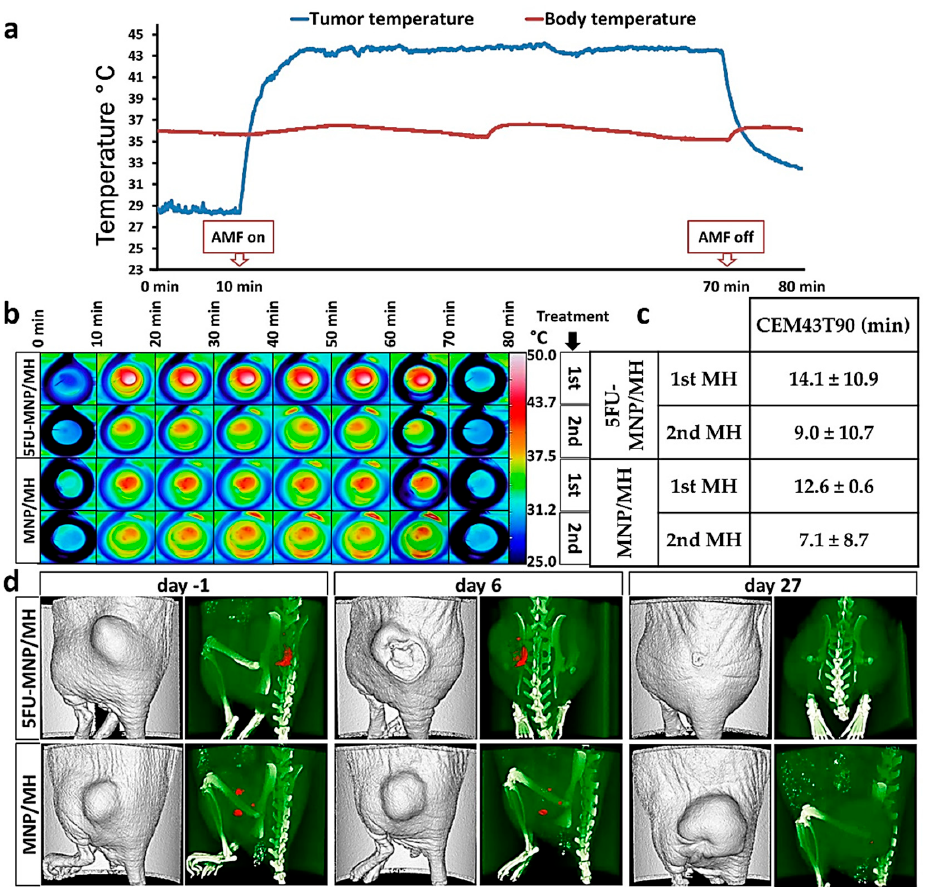
Figure 1. Monitoring the real-time temperature of the tumor and body led to an effective application of magnetic hyperthermia. ( a ) Representative diagram of tumor and rectal temperatures after MNP injection (CS-MNP and 5FU-CS-MNP, 0.25 mg Fe per 100 mm 3 tumor tissue and 0.22 to 0.55 mg 5FU per kg body weight) and exposure to an AMF (60 min at H = 15.4 kA/m, f = 410 kHz), ( b ) heat maps of the tumor surface temperatures as recorded with a thermographic camera, ( c ) mean CEM43T90, calculated for magnetic hyperthermia treatments and ( d ) representative µCT overlay images (bones: white, MNPs: red) taken at 24 h before the first (day − 1) and second tumor therapy (day 6) and 24 h before the animal sacrifice (day 27) showing the clearance of MNPs over time. AMF: alternating magnetic field; MH: magnetic hyperthermia; µCT, micro computed tomography; MNP; magnetic nanoparticle; 5FU: 5-fluorouracil; CEM: cumulative equivalent minutes.